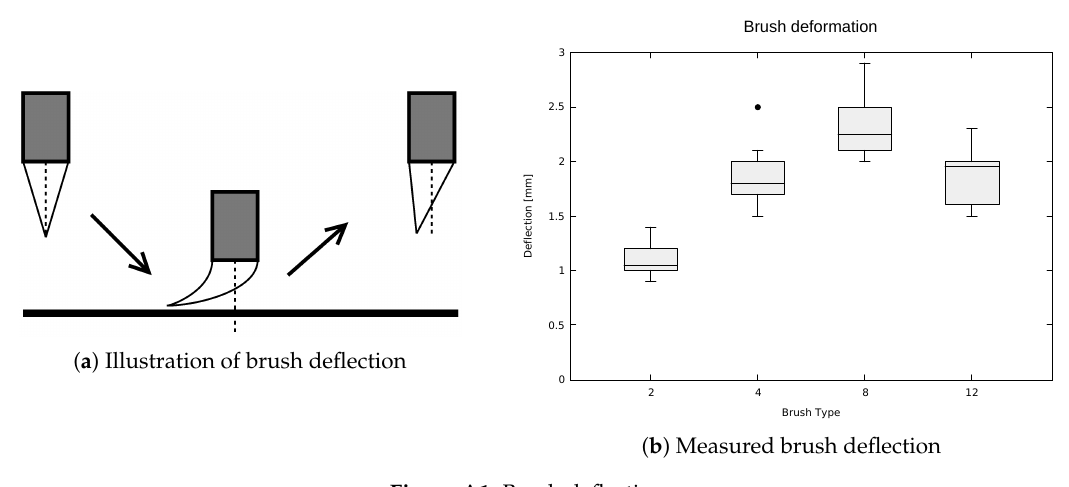
Figure A1. Brush